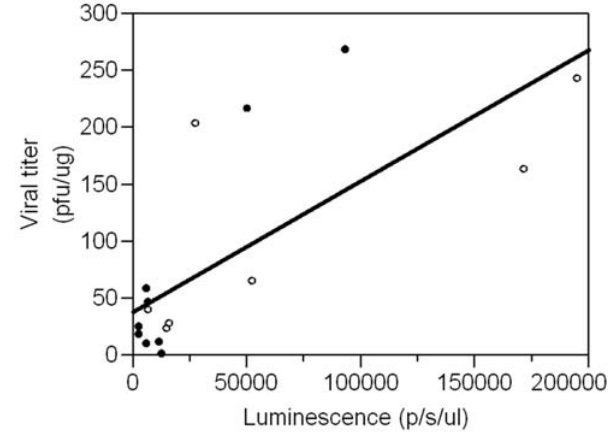
Figure 5. Correlation between viral titers with luminescence levels. The luminescence of kidney, liver, and lung tissue lysates was measured with the IVIS imager. A calibration curve was then generated N using inverse regression analysis and plotting virus titer (PFU/g) against ). MPXV-Congo- luminescence (photons/sec). MPXV-USA-2003-Luc + ( Luc + ( #